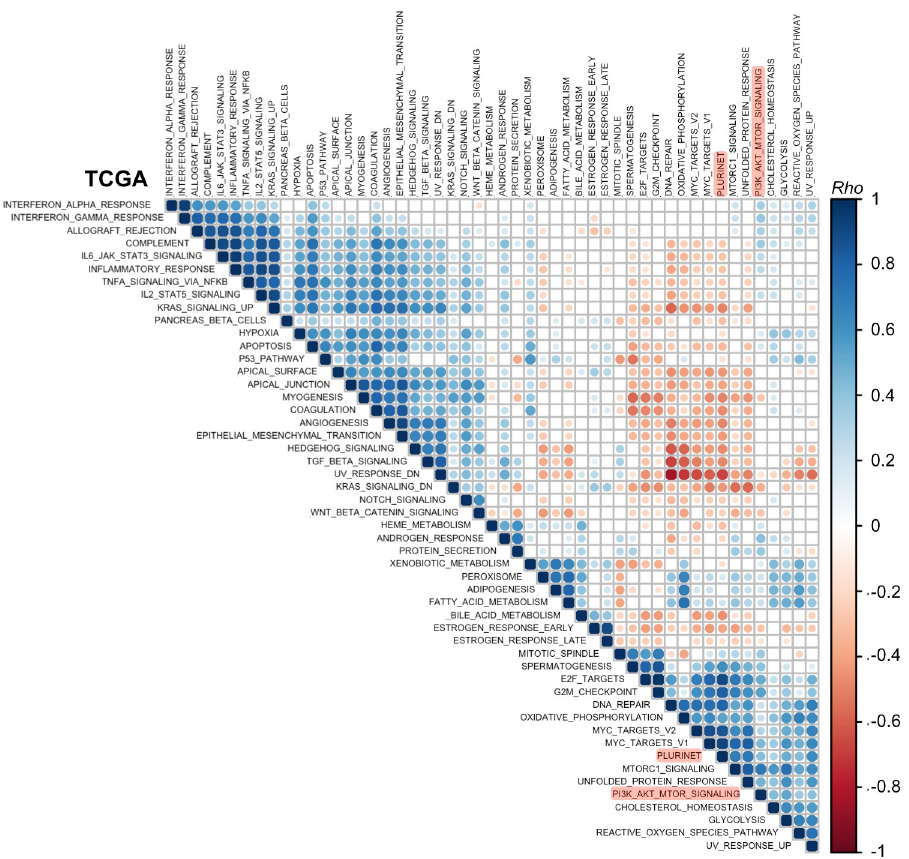
Fig 7. Breast cancer (TCGA cohort) PI3K signaling and stemness scores form a common cluster with proliferative and metabolic processes. As in Fig 6 except based on data from the TCGA breast cancer cohort as